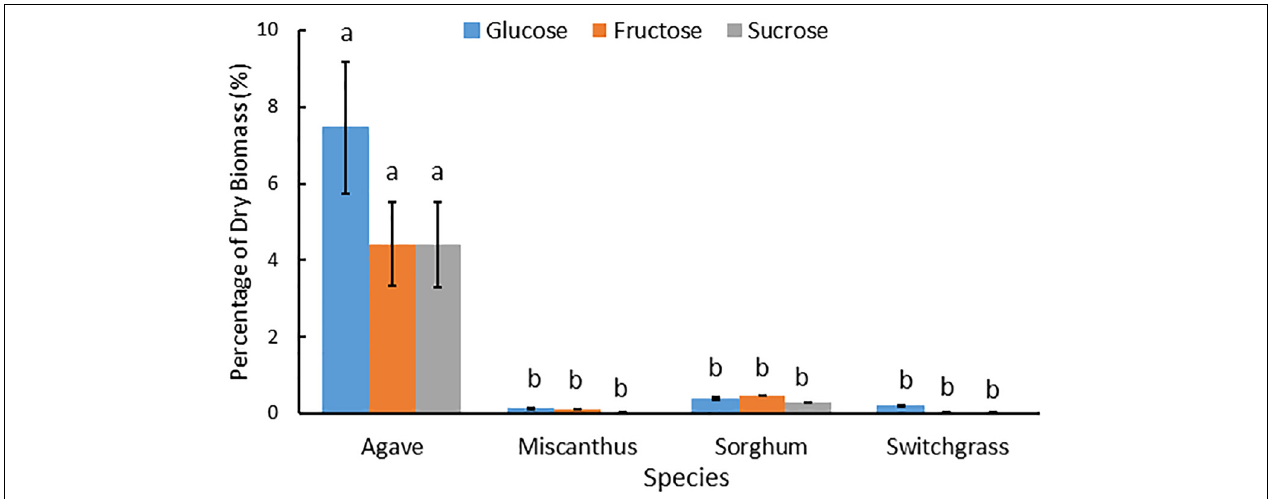
FIGURE 4 | Mean Glc, Fru and Suc as a percentage of dry biomass composition for miscanthus, sorghum, and switchgrass and then all feedstocks including A. americana at a different scale to show relative differences. Error bars indicate standard error of the mean ( n = 16 for A. americana and n = 3 for grasses). All three sugar concentrations were significantly greater in A. americana than in the perennial grasses ( p < 0.05) from one-way ANOVA and Tukey’s HSD test of differences between species within each sugar type, as indicated by lowercase letters.